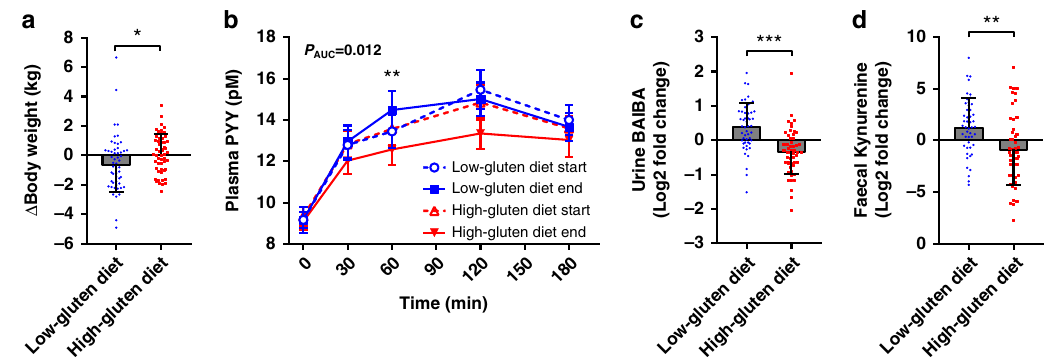
Fig. 5 Low-gluten dieting affects markers of host metabolism. a Plot showing participants ’ changes in body weight following the low-gluten (blue circles) and high-gluten (red squares) periods. b Plot showing participants ’ plasma concentrations of peptide YY (PYY) following a standardised meal at all four visits (low-gluten diet start, open blue circles; low-gluten diet end, blue squares; high-gluten diet start, open red triangle; high-gluten diet end, fi lled red triangle). c Plot showing log2 fold changes in participants ’ urine concentrations of β -aminoisobutyric acid (BAIBA) and d faecal concentrations of kynurenine following the low-gluten (blue circles) and high-gluten (red squares) diet, respectively. Data are shown as means± SEM, n = 50 – 54. Changes were assessed by a linear mixed model adjusting for age, gender and intestinal transit time. * P < 0.05, ** P < 0.01, *** P < 0.001. AUC area under